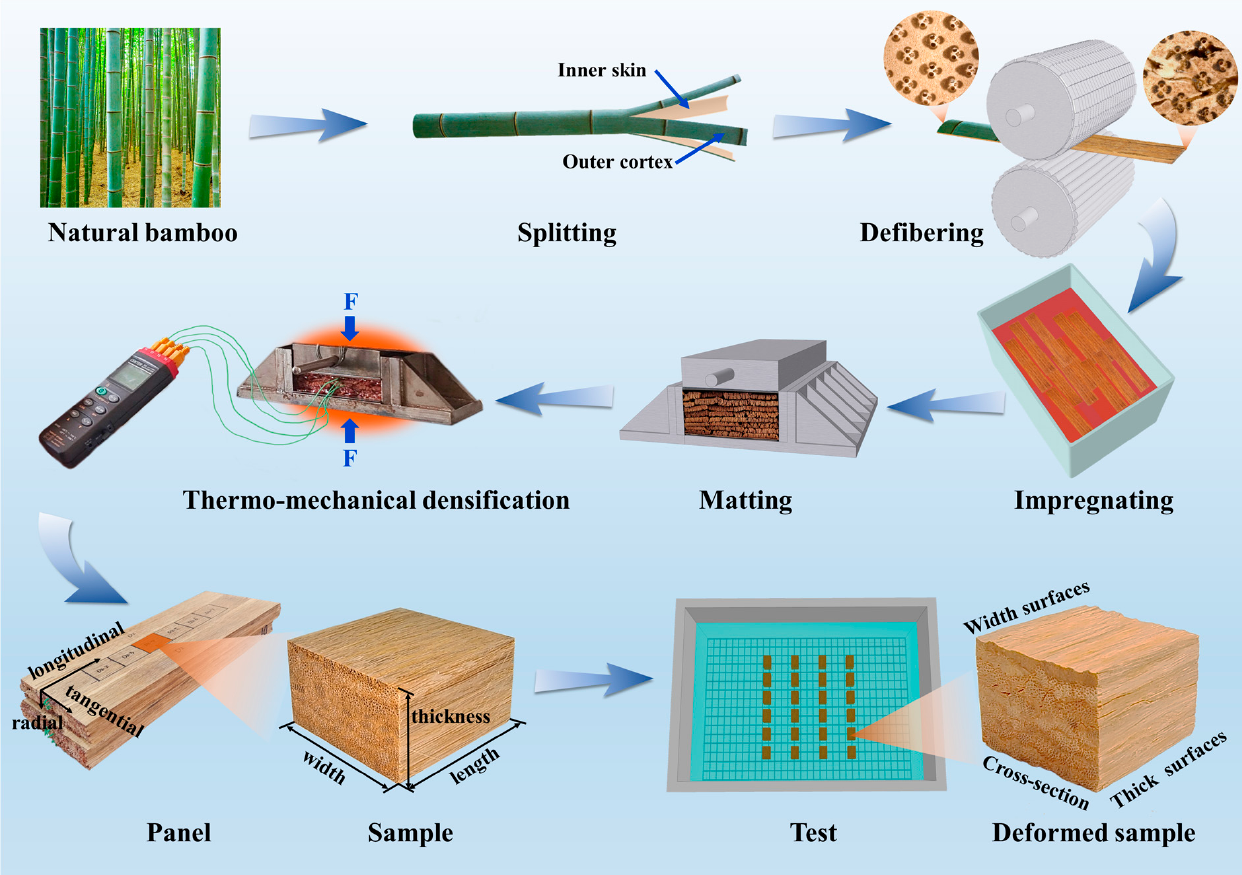
Figure 1. Schematic illustration of outdoor bamboo scrimber preparation and experiment. The bamboo was sawn into bamboo tubes and split longitudinally into four quarter- circular bamboo tubes. The bamboo tubes were pushed into a fluffer to form a net- structured bundle with a width of 50–70 mm and thickness of 6–8 mm, respectively. The moisture content of the dried bundles was 7.6%. The net-structured bamboo bundles were sawn into small segments with a length of 280 mm and infused into the diluted PF resin solution for 5 min at ambient temperature to attain a resin content of 15%. The impreg- nated bamboo bundles were air-dried to a moisture content of 12%. A mat of bamboo scrimber was hand-formed with 8 layers. Bamboo fi bers were oriented along the length of the member in a compression mold. The orientation of the inner skin and outer cortex of